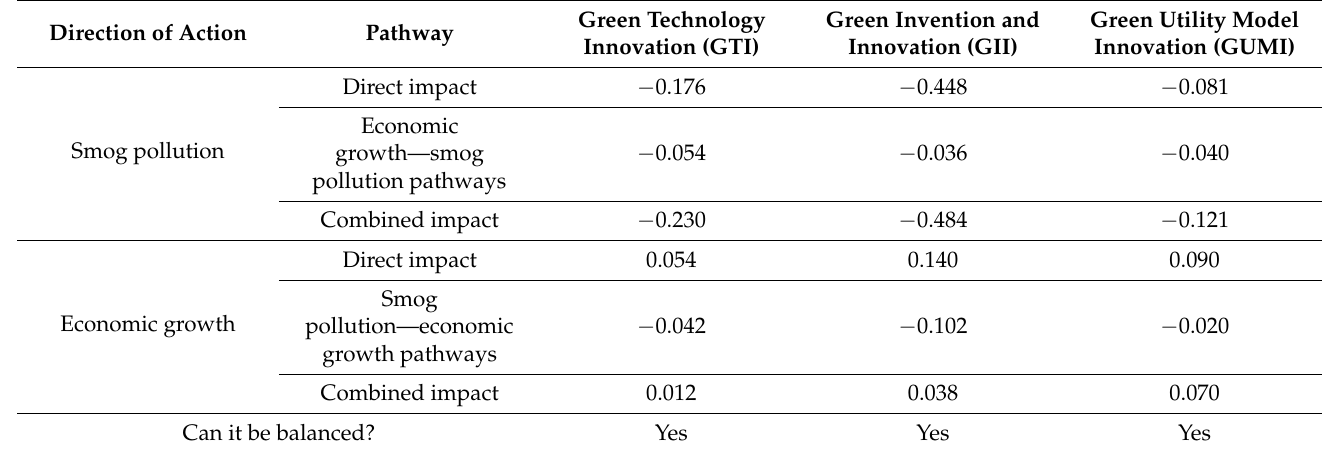
Table 6. Differences in the impact of GTI on SP and